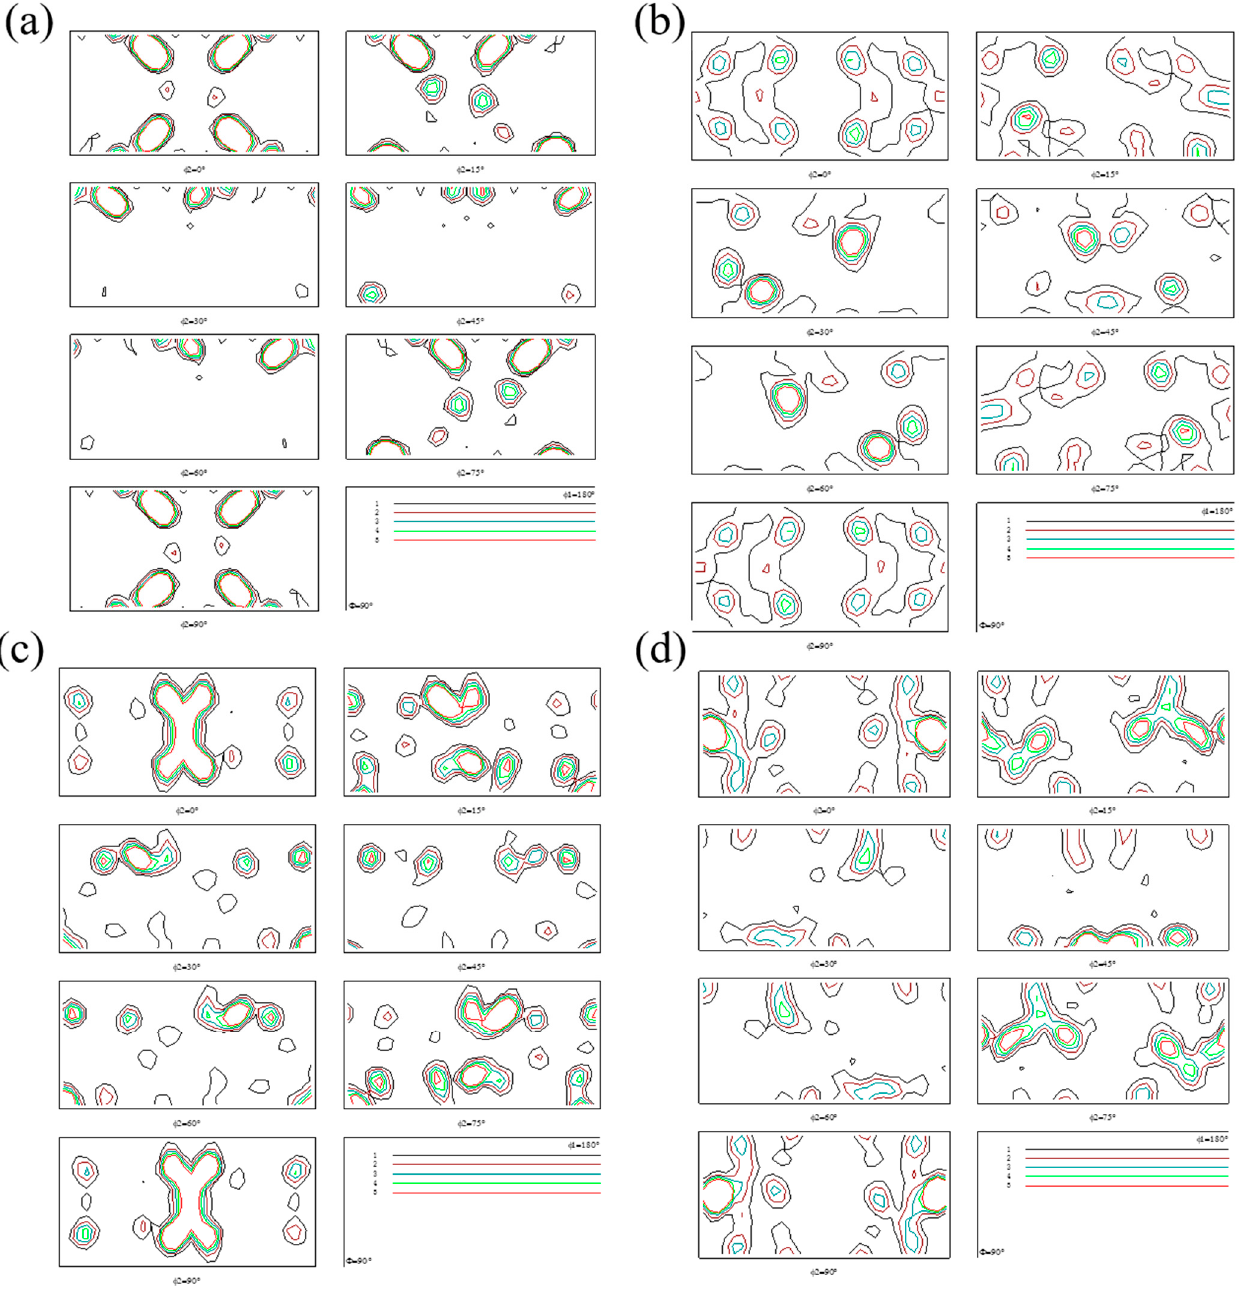
Figure 9. ODF sections of annealed 1561 aluminum alloys: ( a ) the H1 plate;( b ) the H2 plate; ( c ) the N1 plate; ( d ) the N2 plate. N1 plate; ( d ) the N2